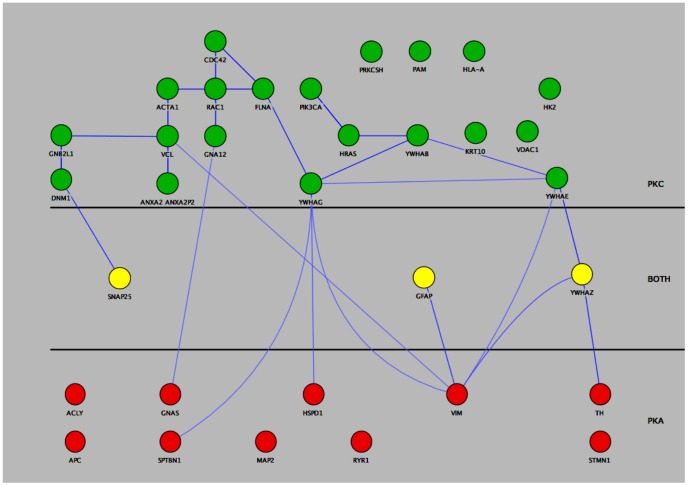
Systems biology analyses distinguishes protein kinase A (PKA) and protein kinase C (PKC) pathways in human DCSV.Human DCSV proteins interacting with PKA or PKC are illustrated in green or red circles, respectively. Proteins interacting with both PKA and PKC are shown in yellow.